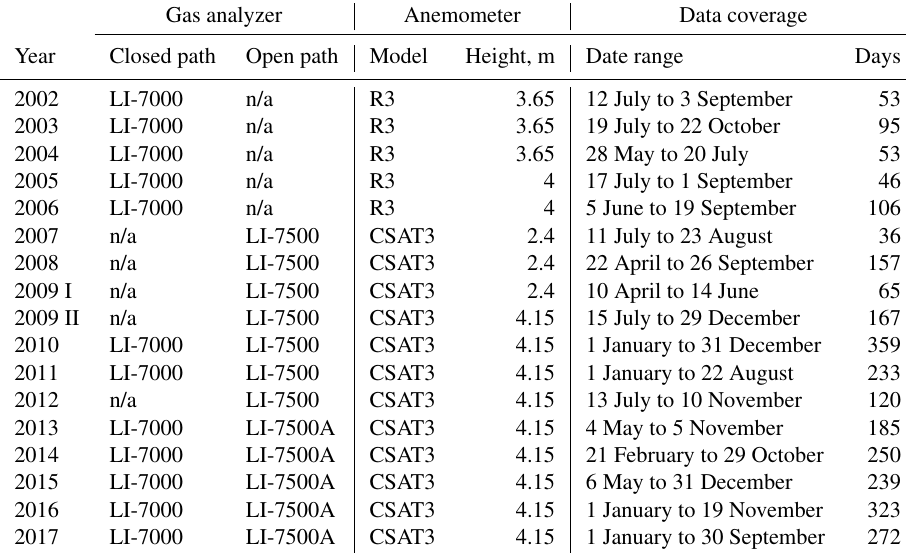
Table 1. List of deployed instrument types. All infrared gas analyzers were manufactured by LI-COR Biosciences (USA), R3 sonic anemometers were built by Gill Instruments Ltd. (UK) and CSAT3 anemometers by Campbell Scientific Ltd.